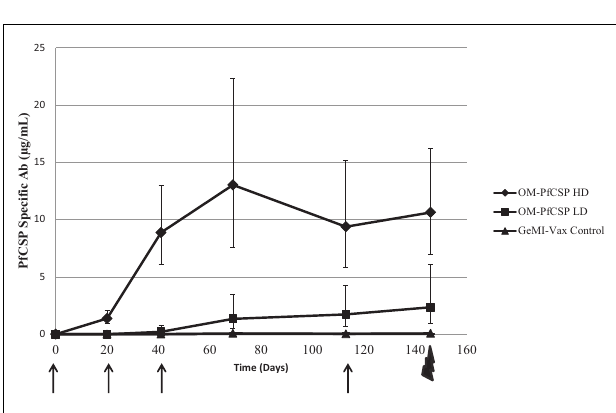
FIGURE 7 |Analysis of expression levels of malarial antigens from the different sub-cellular compartments on Shigella GeMI-Vax . Lysates from GeMI-Vax expressing OM- Pf CSP (A) or PPS- Pf CelTOS (B) were probed with antigen-specific mAbs and polyclonal Abs: cloneWR7 = Pf CSP C-terminus specific mAb; cloneWR3 = Pf CSP repeat region-specific mAb, polyclonal = serum pooled from mice immunized with recombinant Pf CSP;